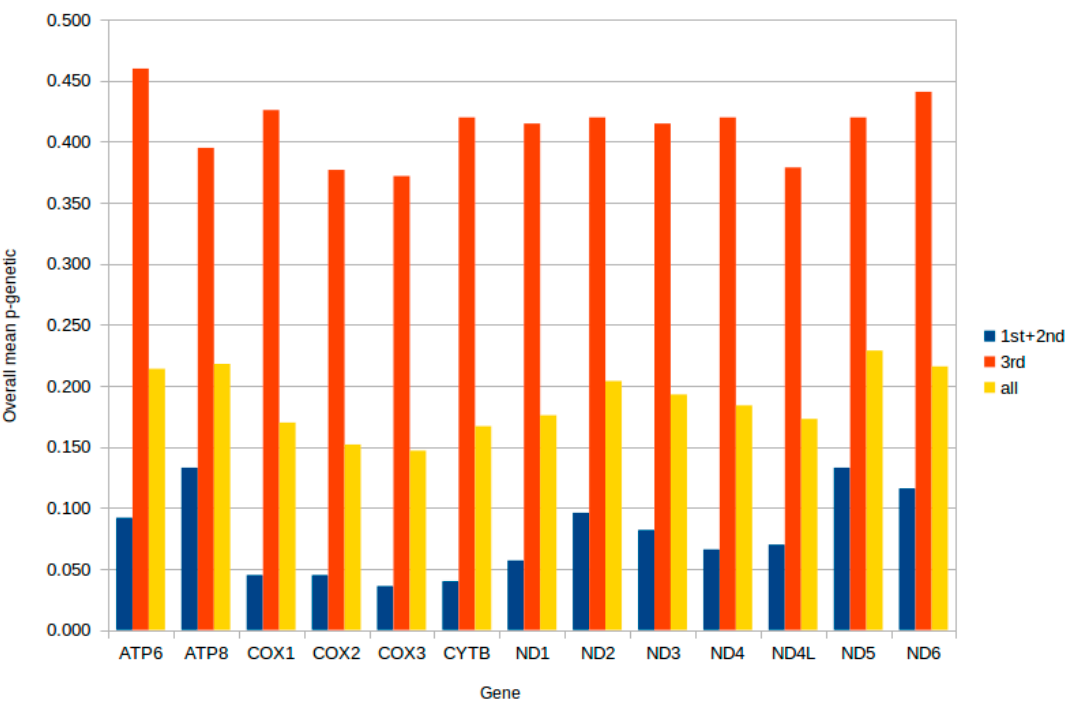
Figure 4. Overall mean p-genetic distance of 19 Sciaenidae species for each of 13 protein genes. They were calculated based on the first and second nucleotide positions, on the third nucleotide position of amino acid codons, and on the full sequence of the 19 Sciaenidae species, respectively. The 19 Sciaenidae species were A. amoyensis (KM257863.1), N. coibor (KM 233452.1), P. diacanthus (KM257722.1), A. japonicus (NC_017610.1), Bahaba taipingensis (NC_018347.1), Chrysochir aureus